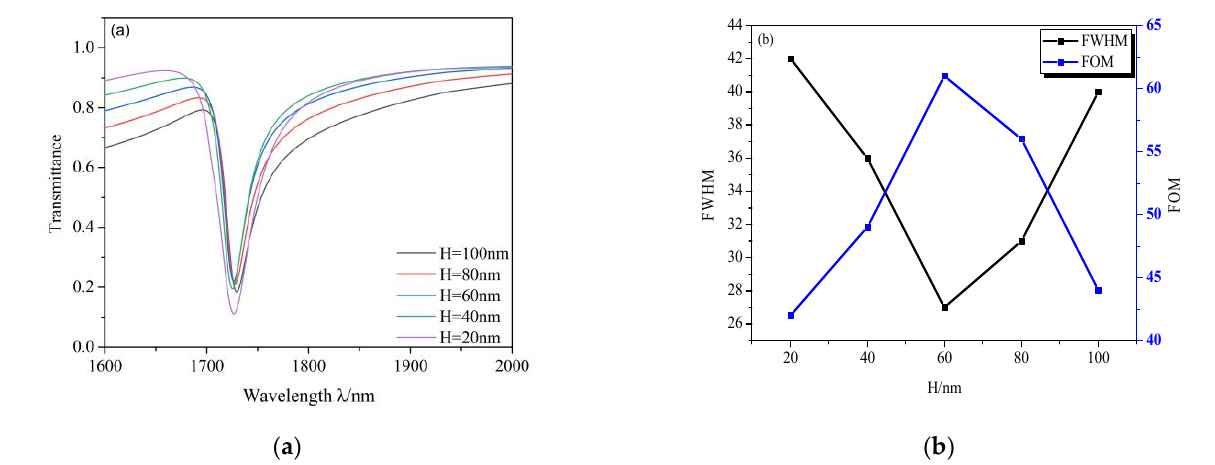
Figure 9. ( a ) Transmission spectra of H varying from 20 to 100 nm; ( b ) the tendency of FWHM and FOM with increasing H .